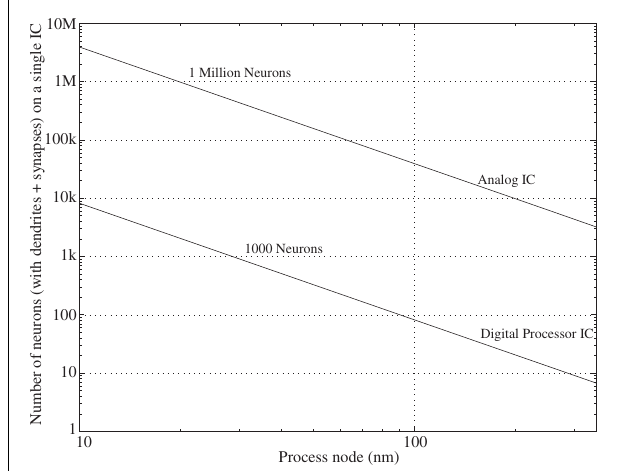
FIGURE 15 | Projection showing the number of neuron computations possible on a single IC (2 × 2cm), assuming both digital and analog computation, as a function of process